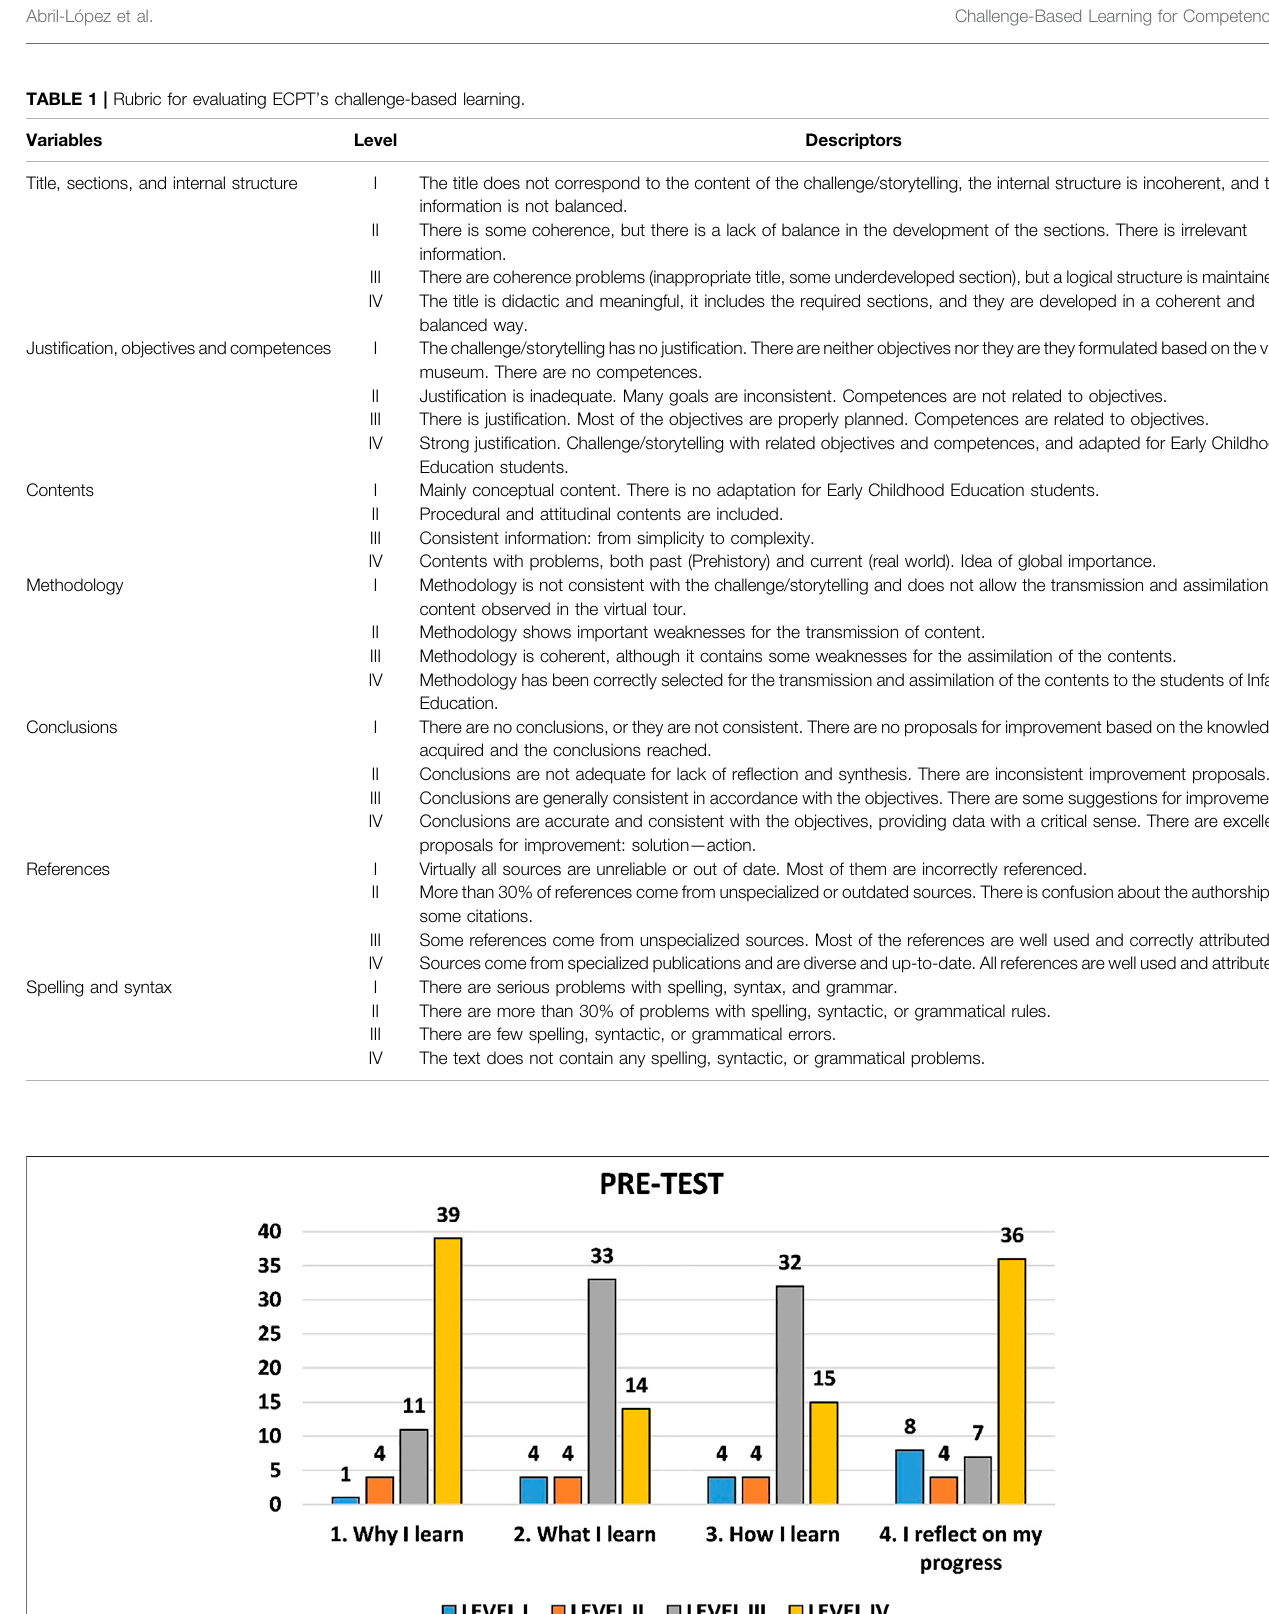
Frontiers in Education |